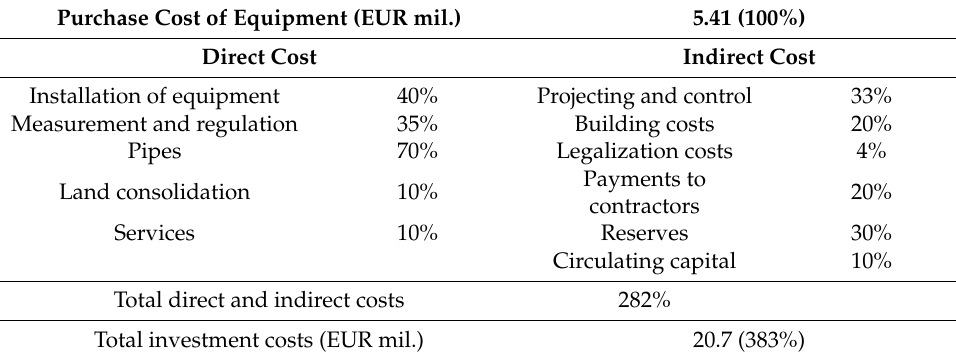
Table 3. Total investment cost estimation [69]. Purchase Cost of Equipment (EUR mil.)